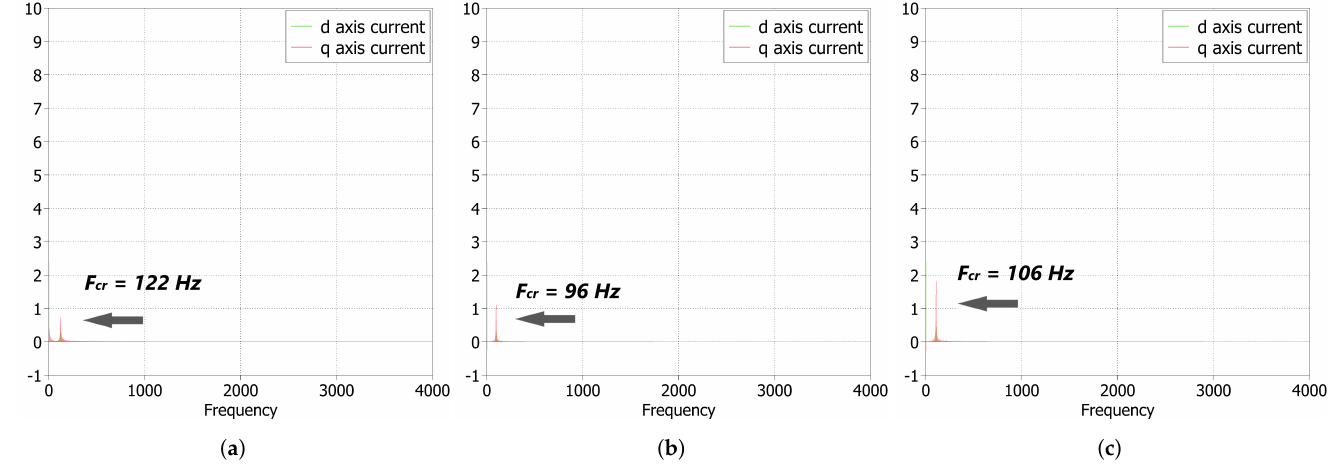
Figure 16. FFT analysis of the VSC inductor current I L for different AVC filter cases in a weak grid (SCR = 1.5). The dominant oscillation frequency is shown when K P , PLL obtains its critical value; ( a ) f AVC,LPF = 20 Hz; ( b ) f AVC,LPF = 50 Hz; ( c ) f AVC,LPF = 100